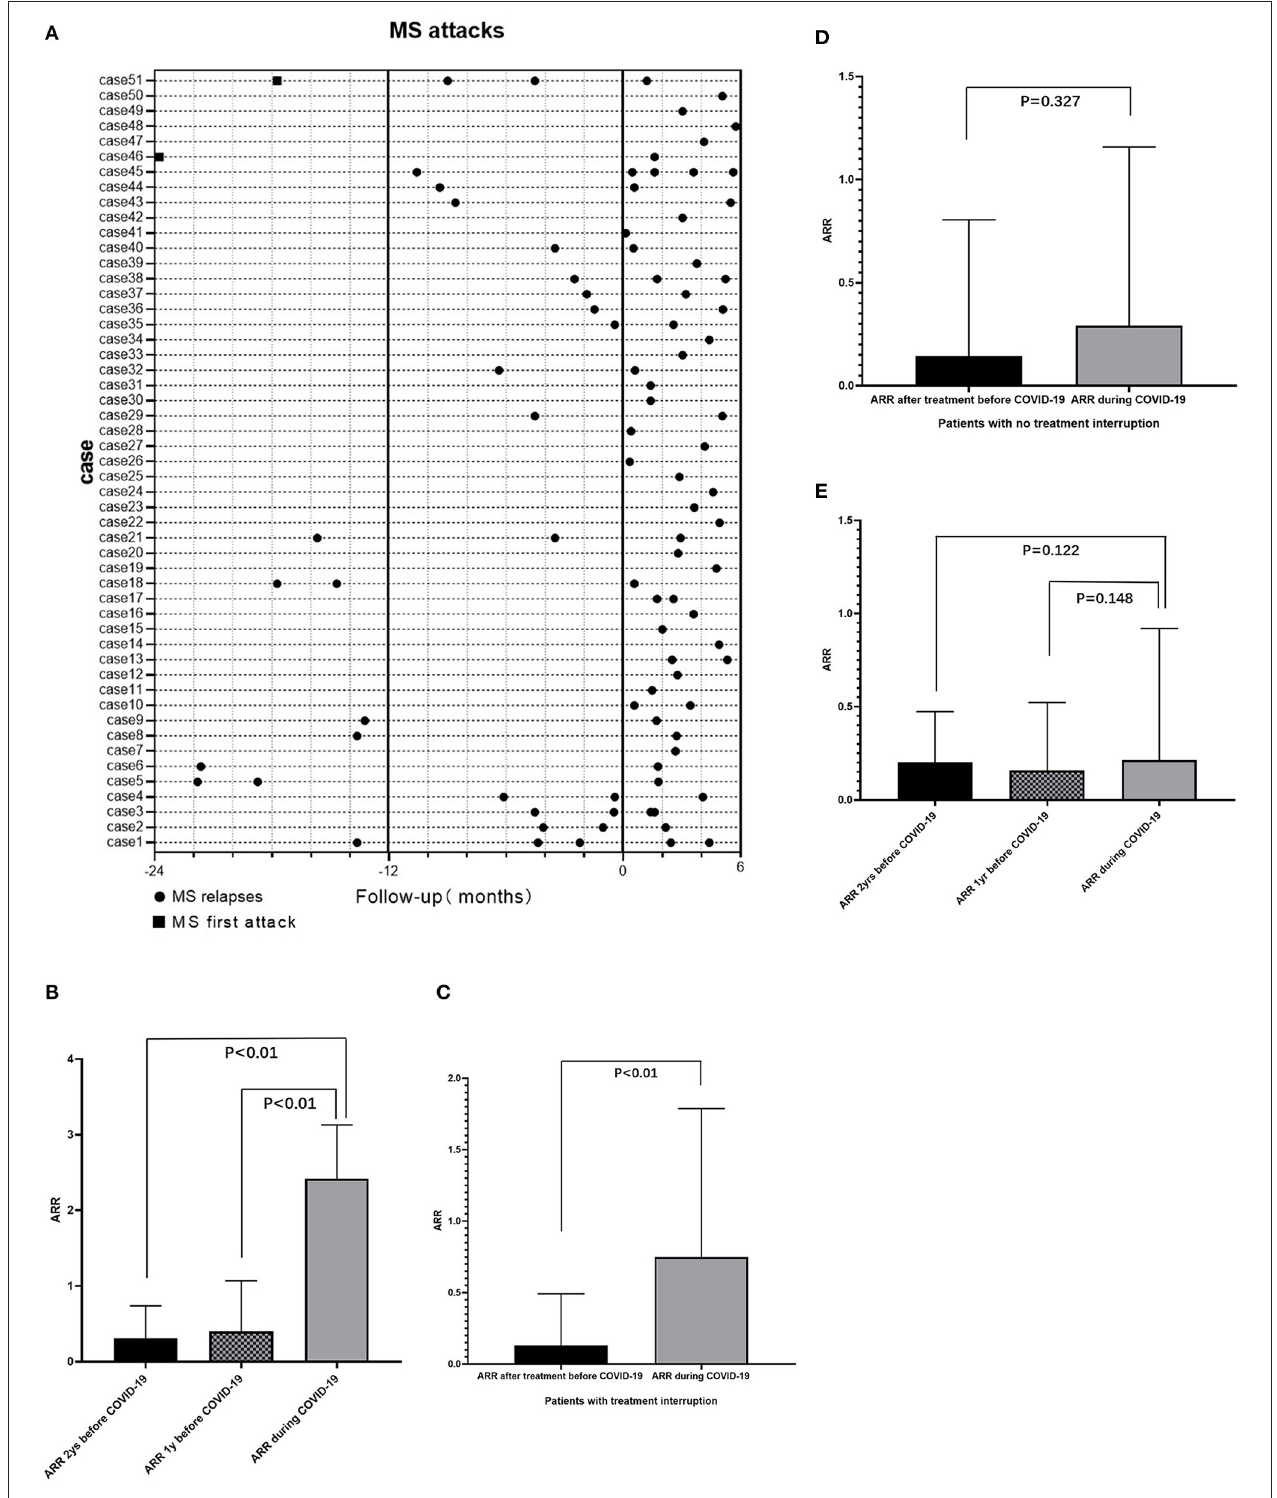
FIGURE 4 | Impact of COVID-19 pandemic on MS attacks. (A) Relapses of 51MS patients who had at least one relapse during pandemic and attacks of this group of patients in 1/2 years before COVID-19 pandemic. (B) For patients who had relapse during the pandemic ( n = 51), compared with 1 year ( P < 0.01) and 2 years ( P < 0.01) before the pandemic, the ARR of patients during the pandemic increased significantly. (C) For patients with treatment interruption ( n = 49), the ARR during the pandemic increased significantly compared with ARR after treatment but before the pandemic ( P < 0.01). (D) For patients with continuous treatments during